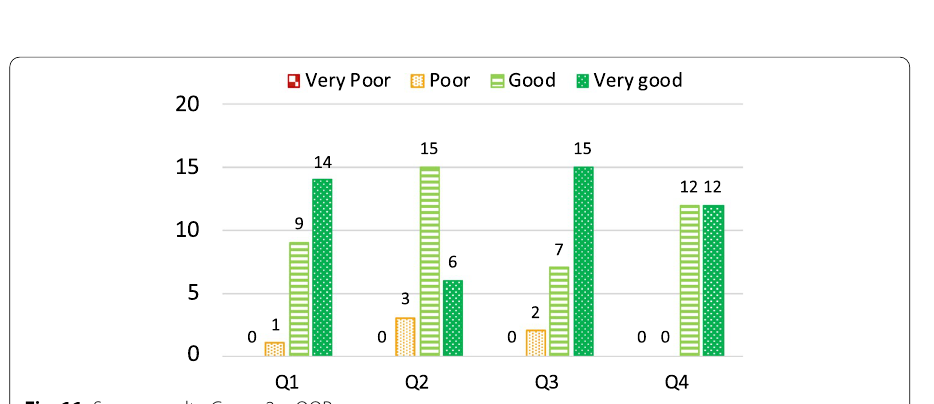
Fig. 11 Survey results: Group